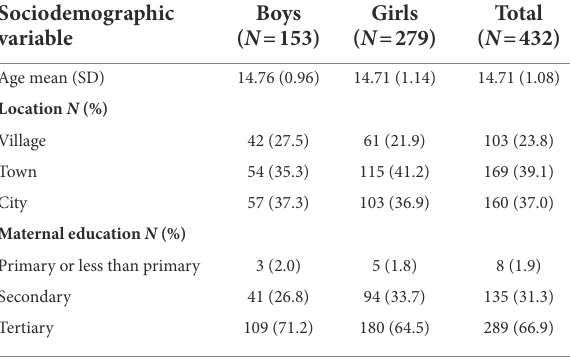
TABLE 1 Demographic characteristics of the sample overall and by gender. Sociodemographic